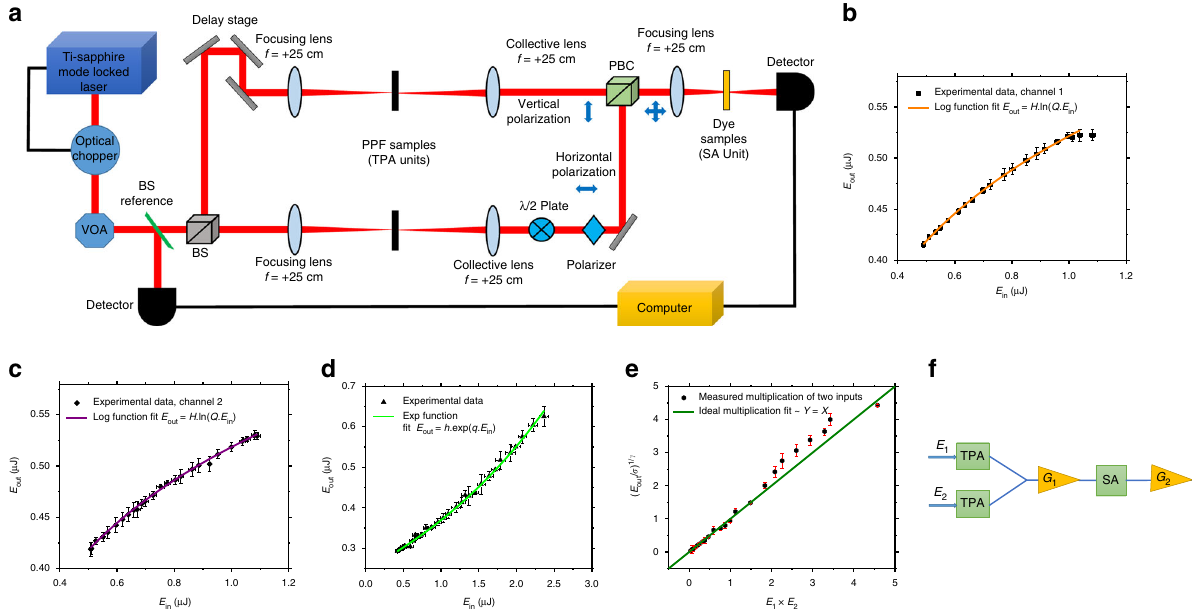
Fig. 4 Experimental multiplication results. a Experimental setup to multiply to input energies. A variable optical attenuator (VOA) and a beam splitter (BS) are used to monitor the input energies to the two photon absorption (TPA) units. A polarization beam combiner (PBC) was used to combine the input energies from two arms as well as preserving their polarization in order to avoid interference at saturable absorber (SA). b , c Experimental TPA data (square) and the nonlinear fi t E out = H .ln( Q . E in ) (solid lines) where H = 0.148 µ J and Q = 33.663 µ J − 1 . The error bars denote the standard deviation of reading input and output energy per pulse for 200 shots for each data point. d Experimental SA data (triangle) and the nonlinear fi t E out = h .exp( q . E in ) (solid line), where h = 0.247 µ J and q = 0.401 µ J − . The error bars are the same as in b , c . e The measured fi nal energy output vs. multiplication of the input values. The solid green line shows ideal multiplication. The error bars show the relative percent error between experimental readout and ideal multiplication of two energy inputs. f Modi fi cation of Fig. 2a schematic capable of performing an ideal multiplication. It requires two gain blocks, G 1 and G